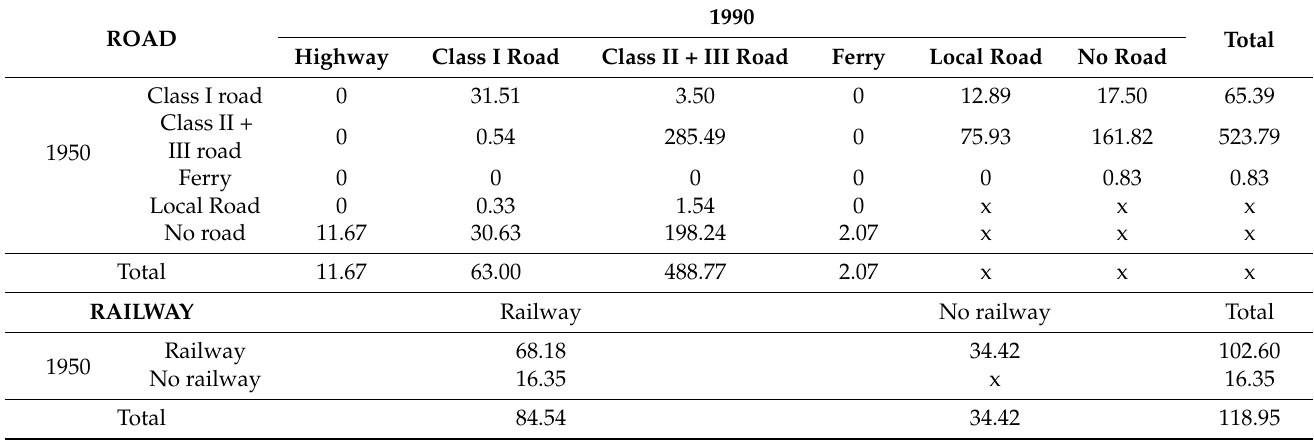
Table 7. The transport network changes: the lakes ( n = 29) constructed in 1950/1990 [km].